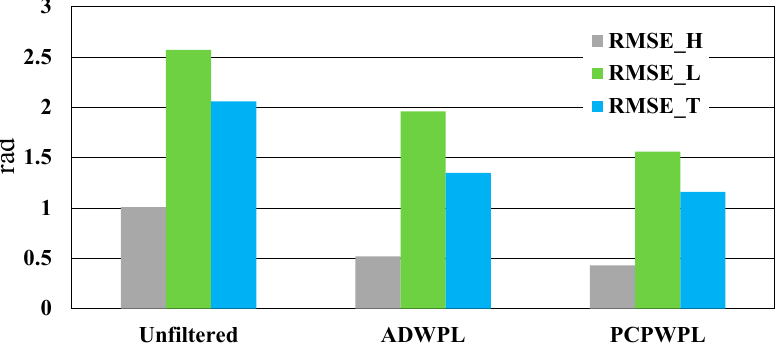
Figure 8. Quantitative comparison of the filtered interferograms with ‘RMSE_H’, ‘RMSE_L’, and ‘RMSE_T’ corresponding to the high-, low- coherence pairs presented in Figure 7, and the total dataset.